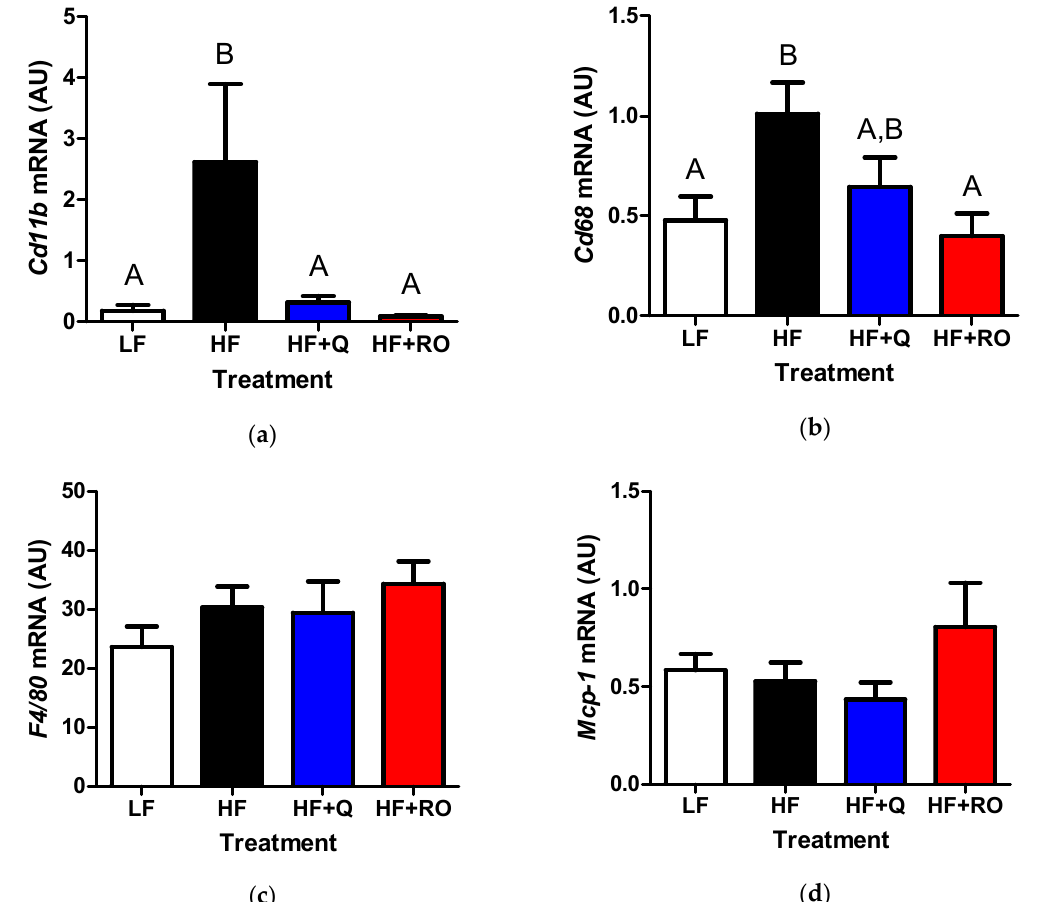
Figure 4. Gene expression for inflammatory markers ( a ) Cd11b ( b ) Cd68 ( c ) F4 / 80 and ( d ) Mcp - 1 were determined in inguinal white adipose tissue (IWAT) from mice were fed low fat (LF; white), high fat (HF; black), high fat + quercetin (HF + Q; blue) or high fat + ROE (HF+RO; red) diets and graphs of respective means ± SEM are shown as arbitrary units (AU). Different letters denote significant differences between groups at p <0.05.